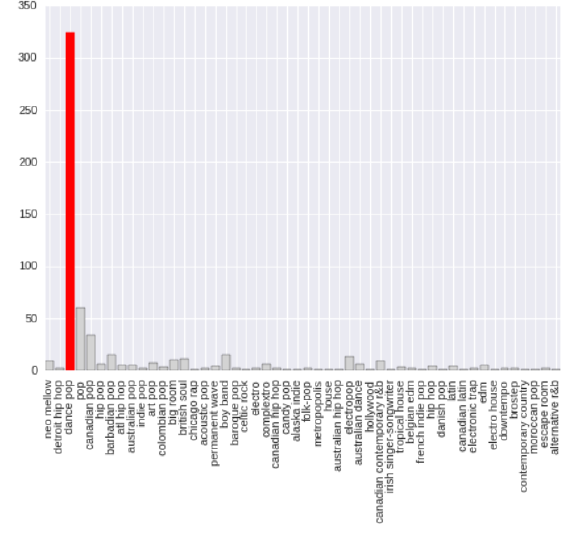
Figure 4. Genres of